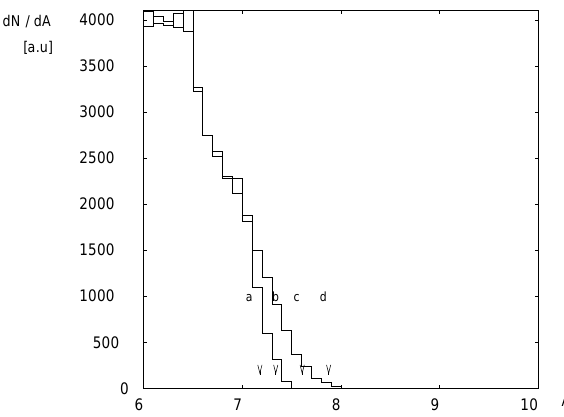
(cid:121) (cid:110) (cid:173) (cid:55) (cid:121) (cid:54) . The present best performance obtained (cid:110) (cid:50) (cid:49)